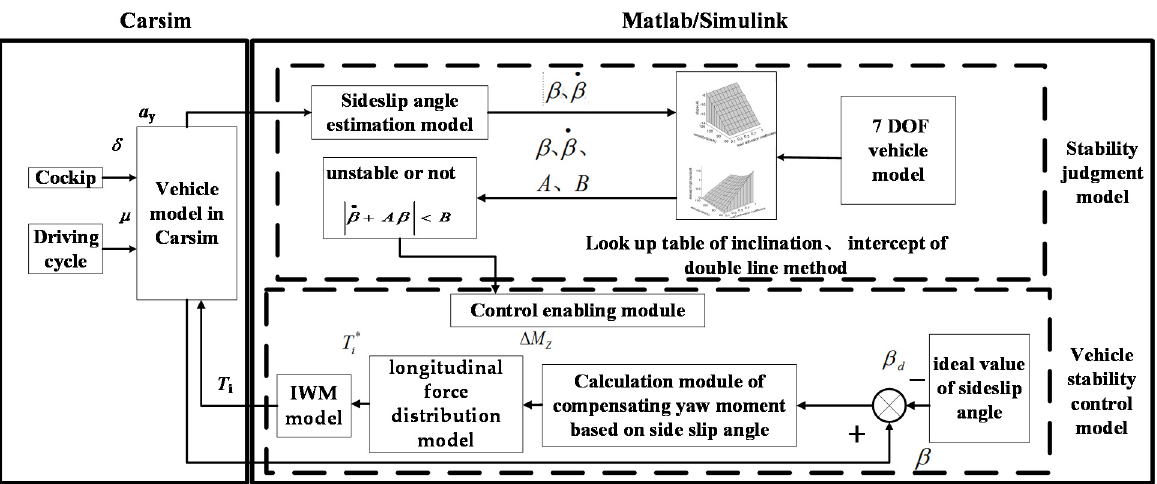
Figure 5. Architecture diagram for cosimulation platform.